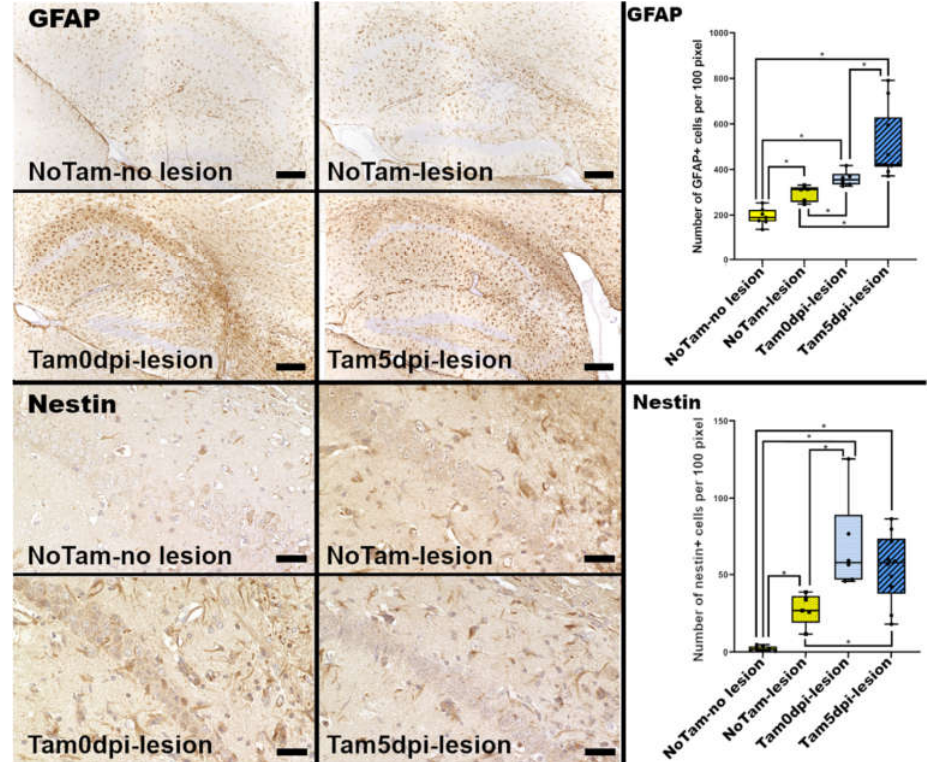
Figure 3. Immunohistochemical evaluation of hippocampi of Theiler’s murine encephalomyelitis virus BeAn (TMEV-BeAn) infected mice 14 days post-infection (dpi). Tamoxifen treatment is associated with astrogliosis characterized by increased numbers of glial fibrillary acidic protein (GFAP)-positive cells in the hippocampus. These nestin-positive cells, most likely representing reactive astrocytes, are similarly increased in tamoxifen-treated animals at 14 dpi. Scale bars: 200 µ m (GFAP) and 50 µ m (nestin). Statistical significant differences are depicted as * = p ≤ 0.05 (Supplemen- tary Table S1 for each p -value